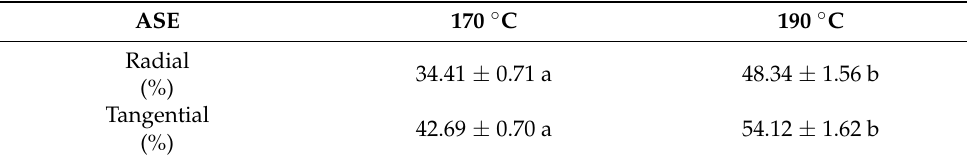
Table 2. Anti-swelling efficiency (ASE) of thermally modified Pinus oocarpa .